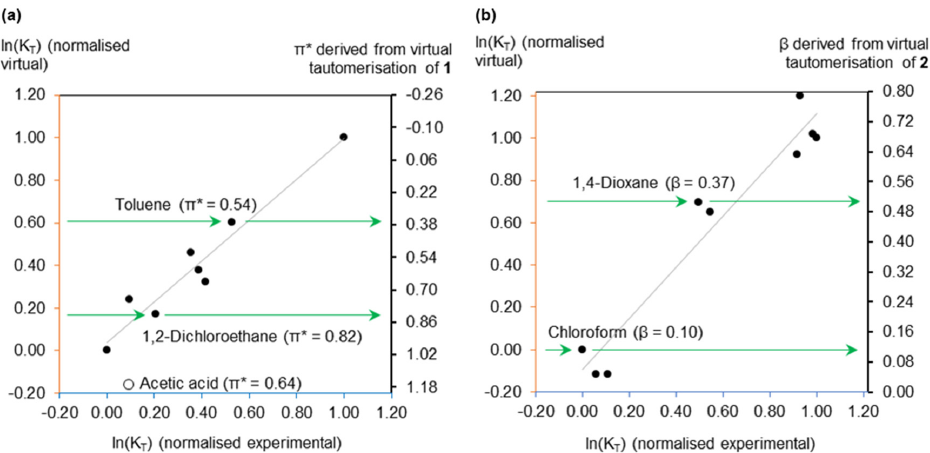
Figure 2. Model training datasets to establish the relationship between experimental and virtual equilibrium constants. ( a ) The π * calculation, annotated with the most accurate prediction (1,2- dichloroethane) and the least accurate (toluene). Acetic acid deviated from the trend; ( b ) The β